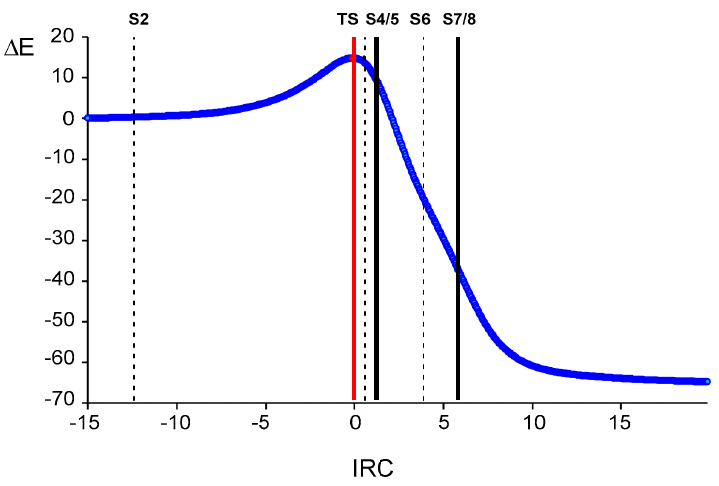
Figure 5. MPWB1K/6-311G(d) intrinsic reaction coordinates (IRC) associated with the 32CA reaction of diphenyl NI 1 and allenoate 4 yielding pyrazoline 6 via TS11 . The positions of the selected structures S2 – S8 of the IRC are shown.